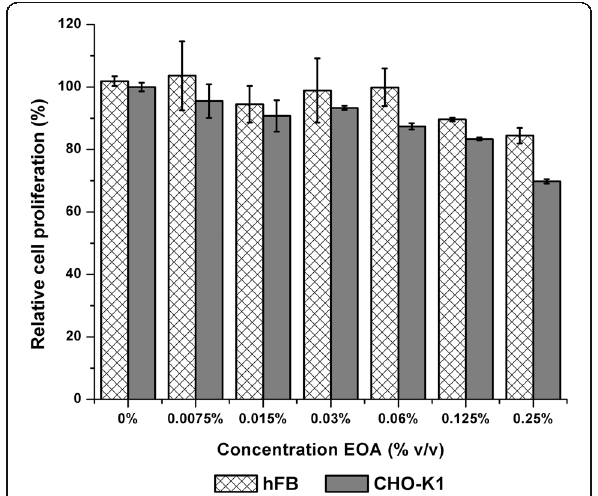
Fig. 2 Effect of aqueous extract (AAE) on cell lines CHO-K1 and hFB by the MTT test. Error bars represent standard